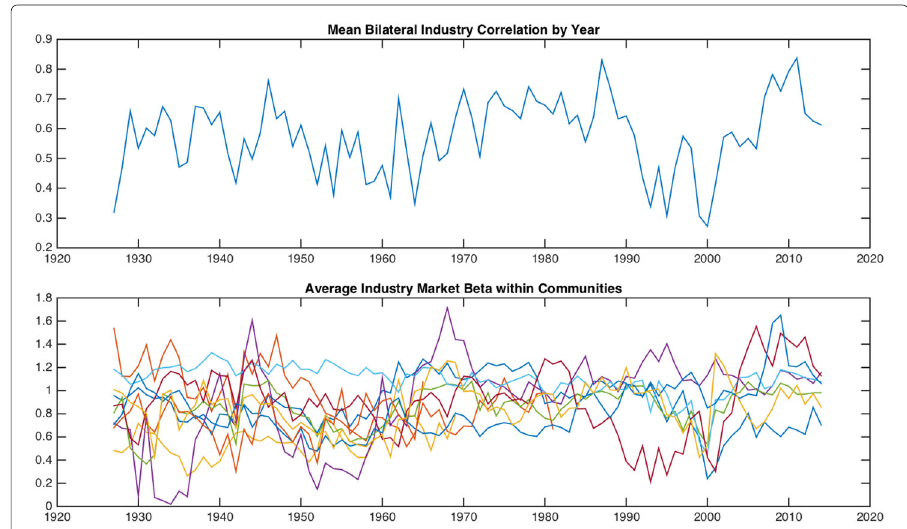
Fig. 4 AggregateCorrelationandIndustryBetas. The top panel plots the average pairwise correlation of all 30 industries for each year in the sample. We observe that there is no discernible trend in overall industry correlation over the period that we study. The bottom panel plots the average industry market beta for each community in each year. While there are differences in market beta across communities, these differences are not persistent, suggesting that time-varying loadings on to the first principal component of returns are not sufficient to explain our